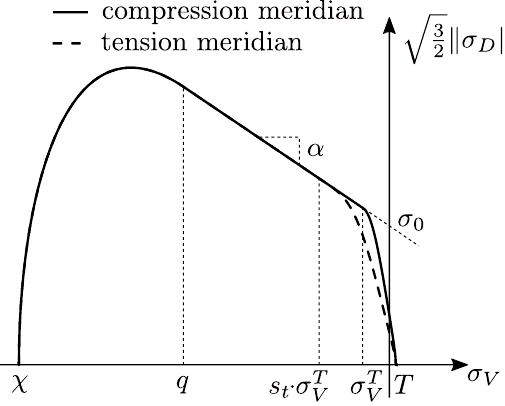
Figure 5. Initial smooth microplane cap yield